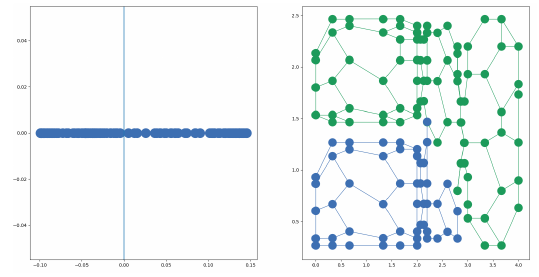
Figure 5. Median cut in G based on its eigenspectrum.